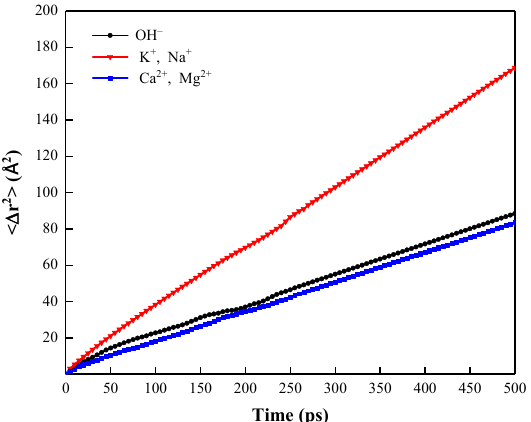
Figure 11. Mean square displacement of OH − and cations in “SDBS/HPAM/OH − ” system.